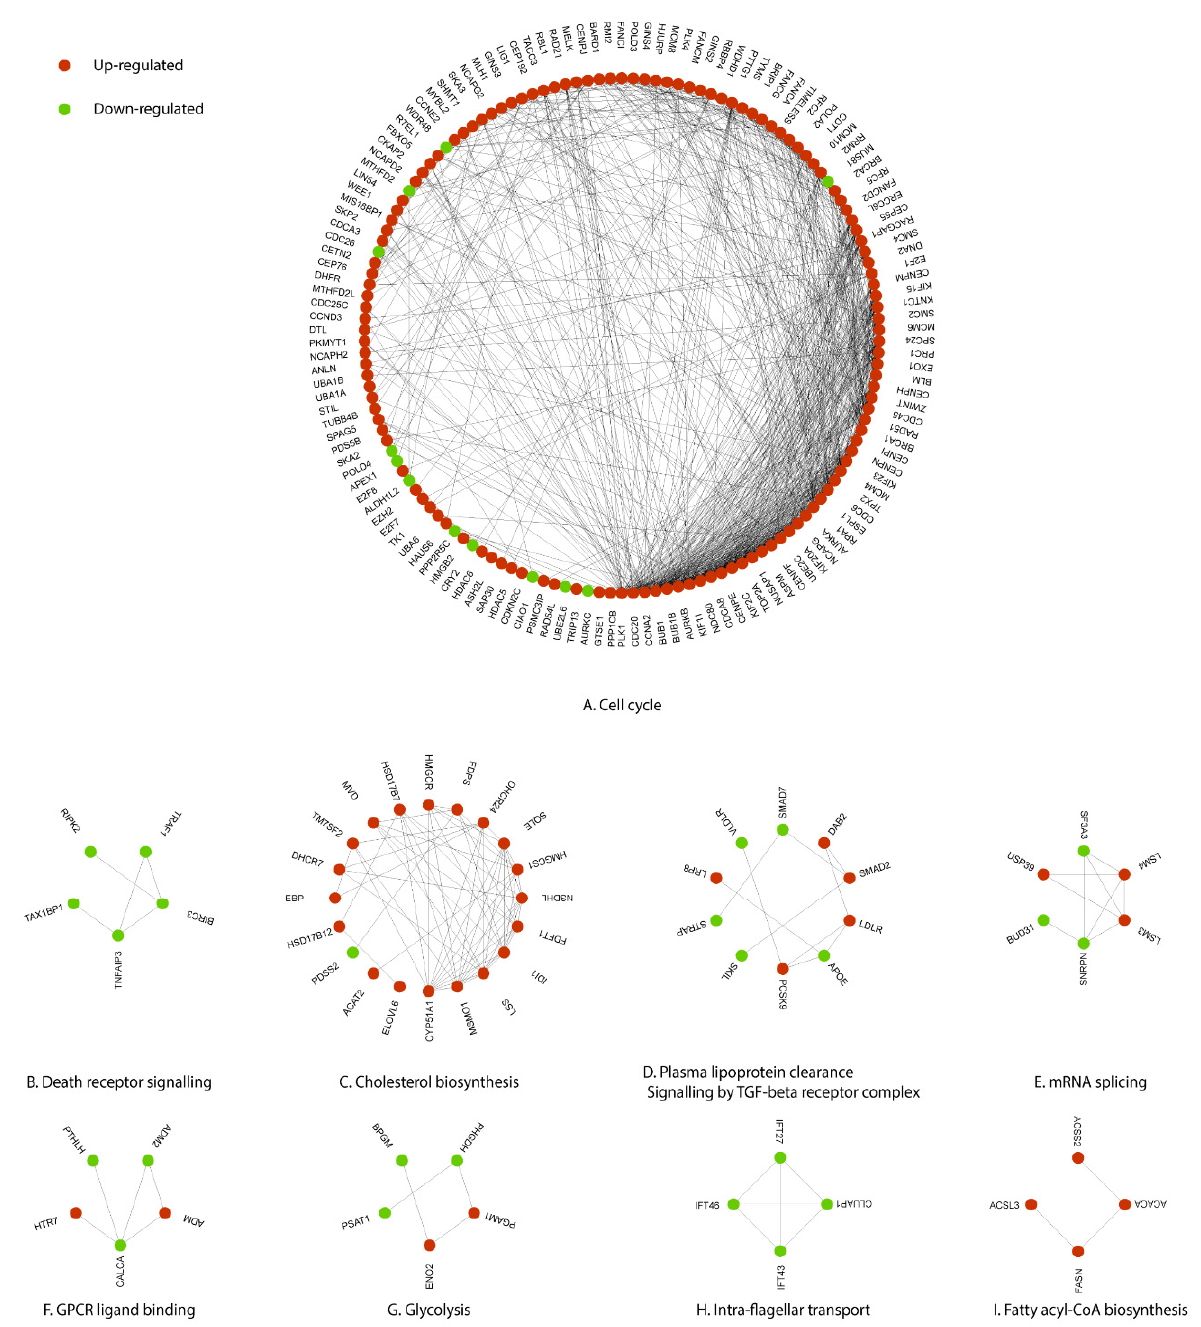
Figure 5. Perturbations of the signalling networks in A549 cells induced by polymyxin B treatment. ( A ) Cell cycle is the largest connected component containing 142 nodes and 804 edges; ( B ) Death